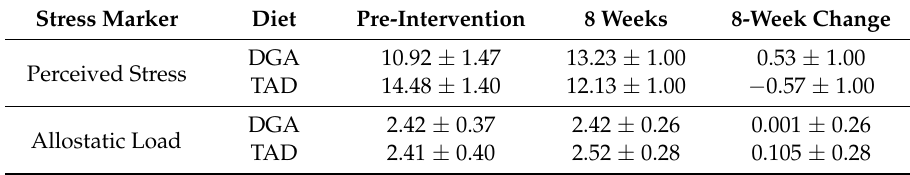
Table 1. * Effects of diet intervention on perceived stress and allostatic load.